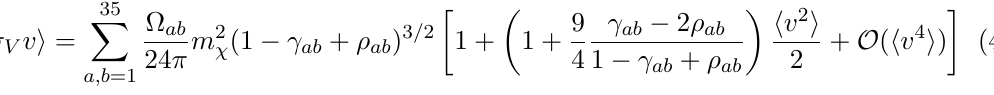
plotted for M S = (cid:31) with (cid:31) (cid:31)